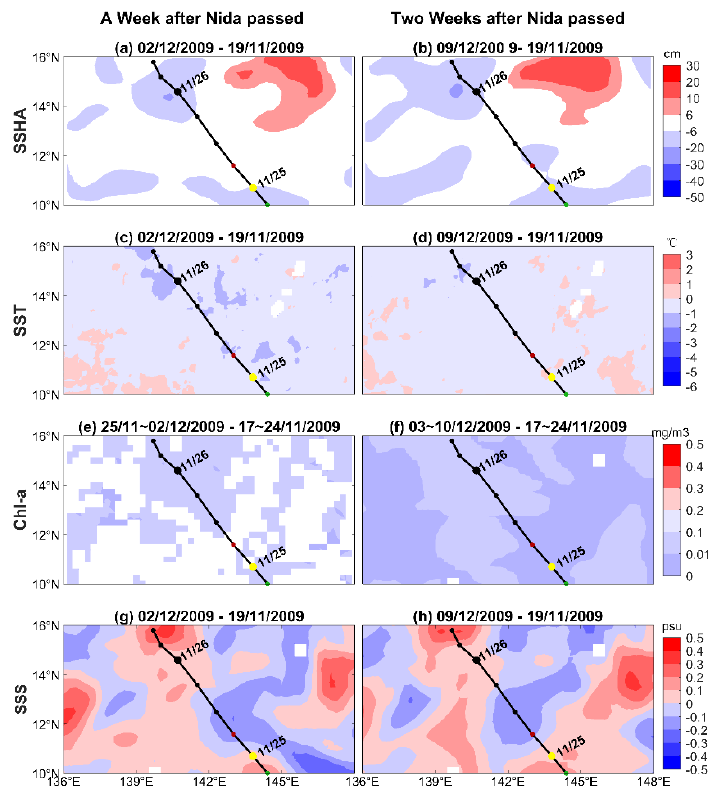
Figure 5. The straight-line stage. ( a , b ) The SSHA fields (shaded, cm) on 9 and 15 December 2009, indicating one week and two weeks after the passage of Nida, respectively. ( c , d ) The SST responses (shaded, cm) on 9 and 15 December 2009. ( e , f ) The chl-a responses (shaded, cm) several weeks after the passage of typhoon Nida. ( g , h ) The SSS responses (shaded, cm) on 9 and 15 December 2009.